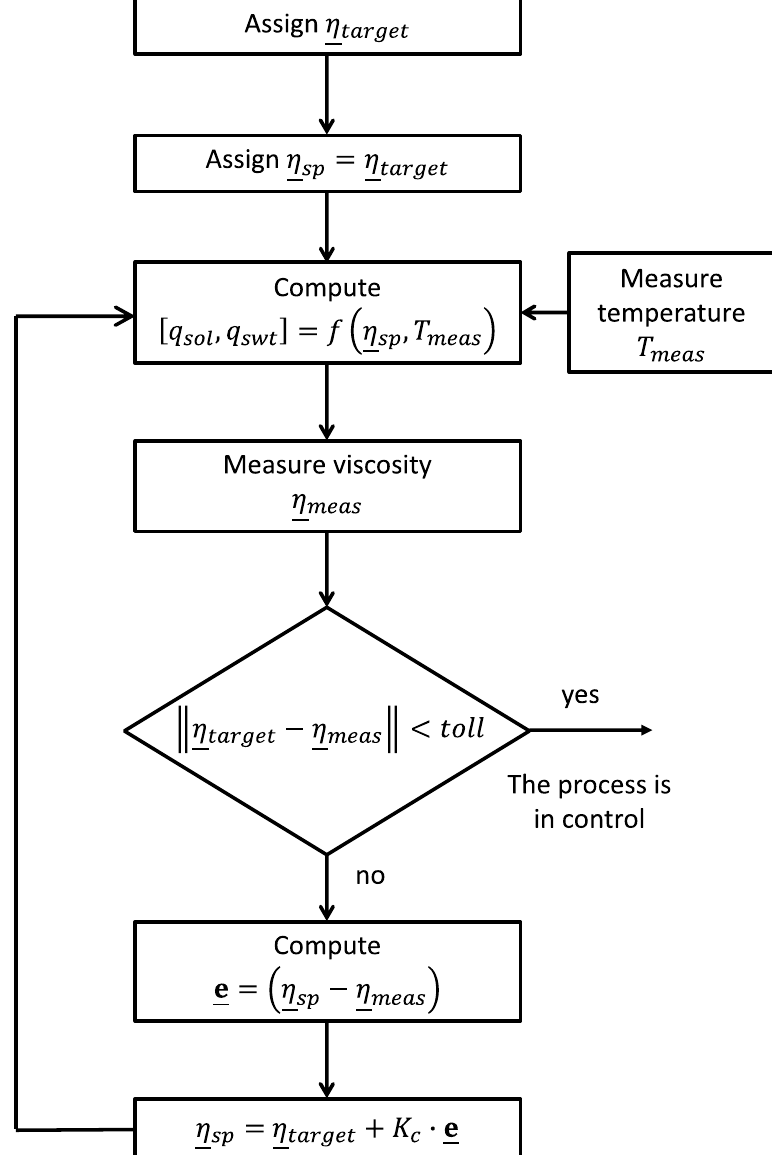
Figure 9. Decision support algorithm .